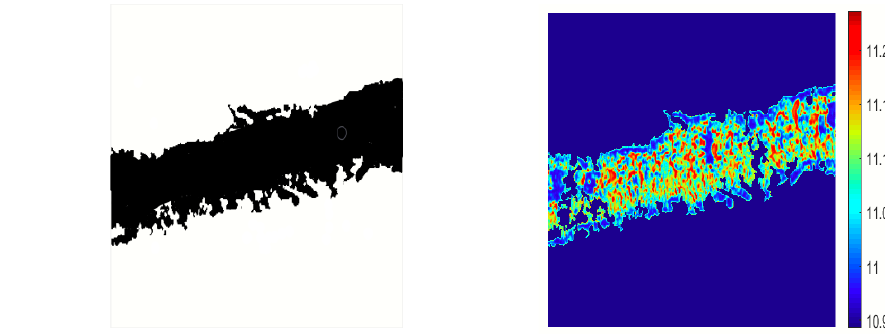
Figure 8. Spatial distribution visualization of POD activity in tomato leaves based on PLSR model.